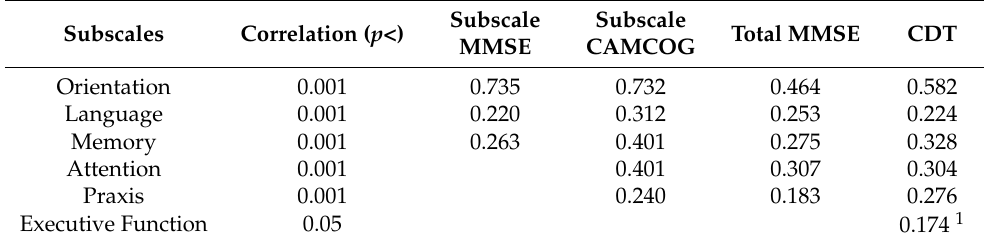
Table 1. Correlation of NNCT